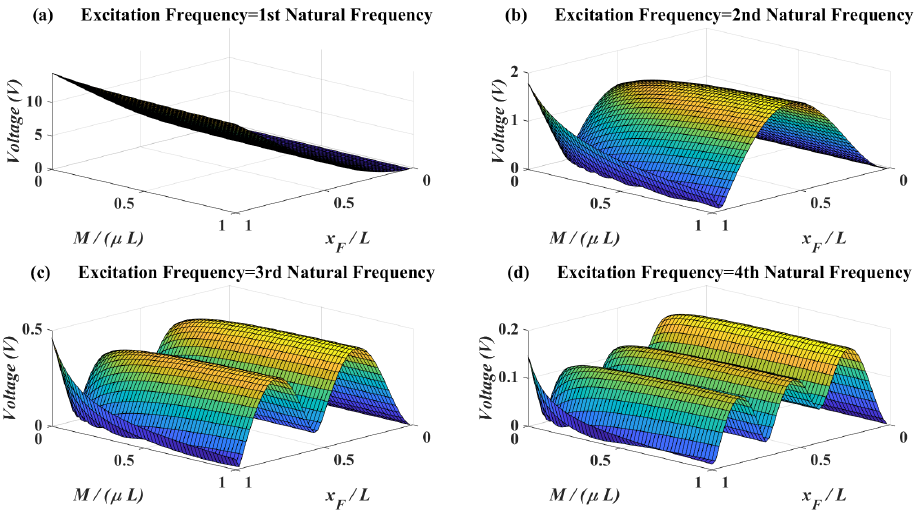
Figure 6. Piezoelectric voltage amplitude for different attachment mass vs. force location— l 1 = L , J = 0, l p 1 = 0.01 L